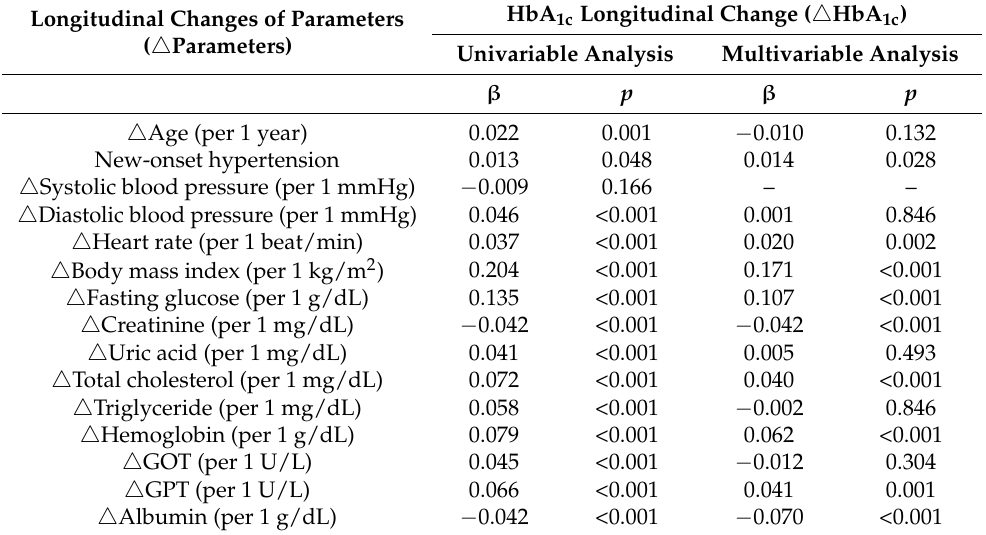
Table 3. Correlation between HbA 1c longitudinal change and longitudinal changes of other parame- ters in the univariable and multivariable